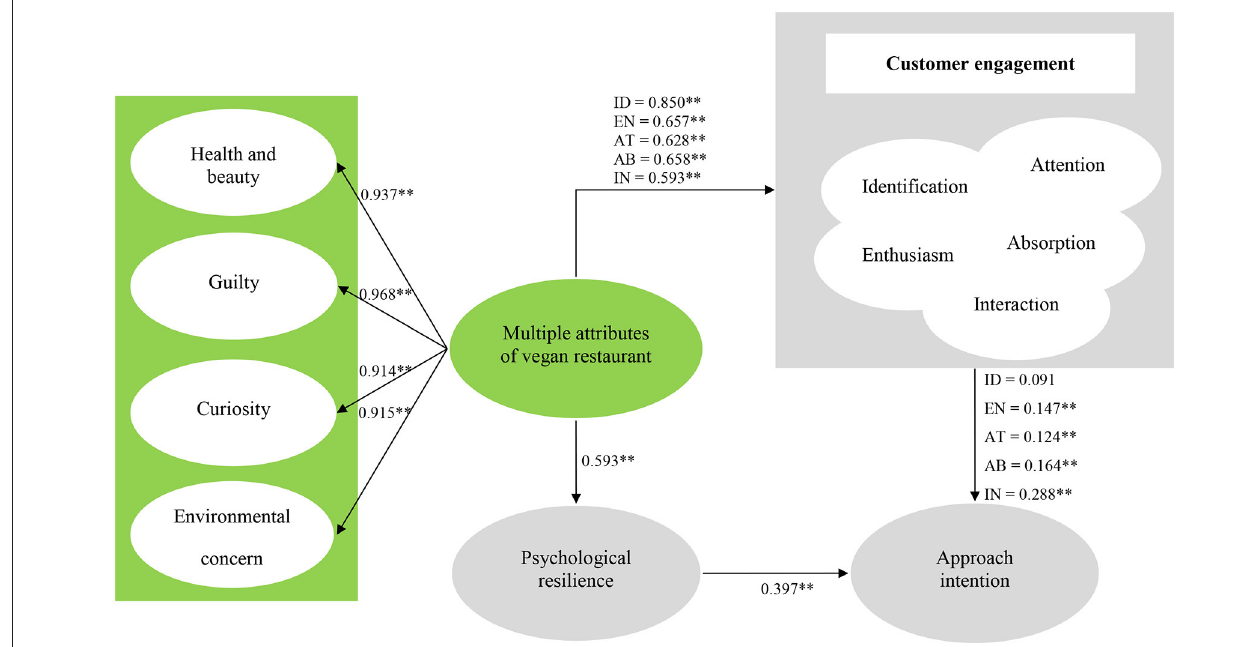
FIGURE 2 | Results of structural model. * p < 0.05, ** p <